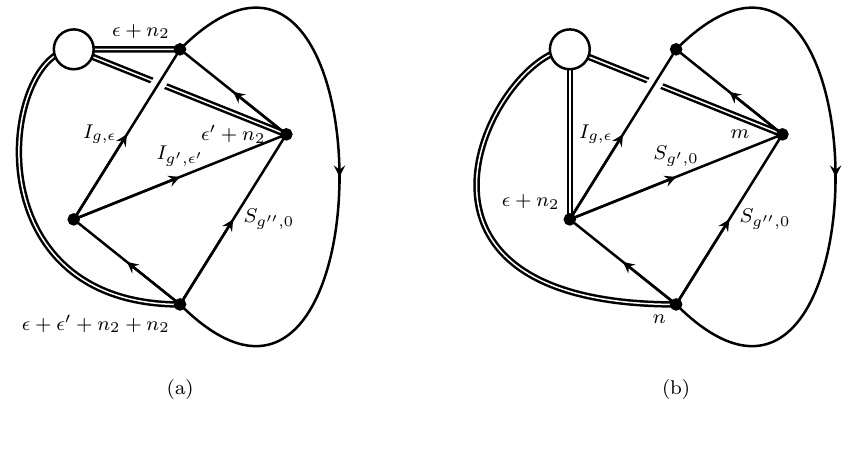
Figure 24 . Two sample computations of associators for a phase corresponding to long exact sequence. The values at the starting of double lines encode the number of P 1 ; 1 lines. We leave the argument of n 2 self-evident as it can be read from the diagram. m and n are numbers (de(cid:12)ned modulo 2) associated to the choice of morphisms at the junctions where two S lines converge and diverge respectively. m is 1 if it corresponds to the morphism S (cid:10) S ! P and 0 if it corresponds to S (cid:10) S ! I . n is de(cid:12)ned similarly. The graph in (b) evaluates to a non-zero number only if n 2 ( g 0 ; g 00 )+ n 2 ( g; g 0 g 00 ) + n 2 ( gg 0 ; g 00 ) + (cid:15) + m + n = 0 which is the same as n 2 ( g; g 0 ) + (cid:15) + m + n = 0. As a result of this, the double lines always come in pairs. The graphs in (a) and (b) imply that the associators respectively are ( (cid:0) 1) (cid:15) ( (cid:15) 0 + n 2 ( g 0 ;g 00 )) (cid:23) 3 and (cid:21) ( m +1)( n +1) ( (cid:0) 1) (cid:15)m (cid:23) 3 where (cid:21) is a square root of